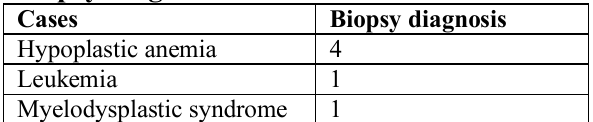
Table II: BMTB diagnosed cases in